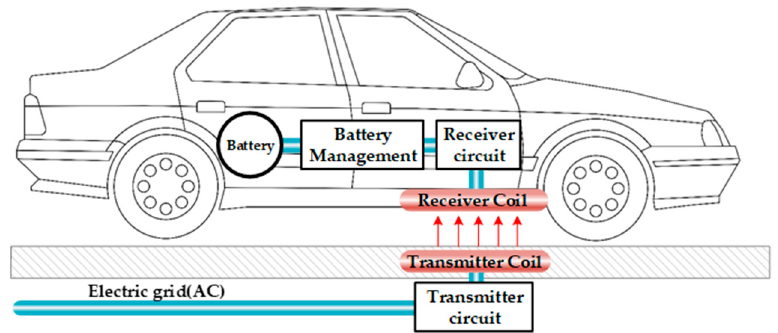
Figure 3. Wireless power transmission system of an electric vehicle.